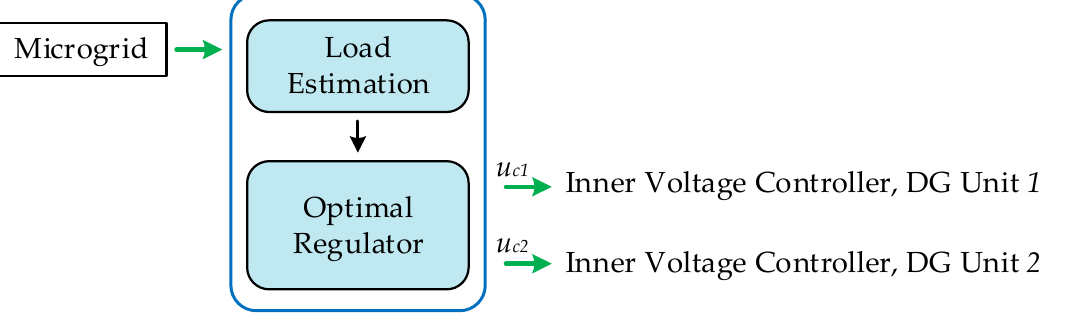
Figure 1. Design procedures of the proposed control strategy.